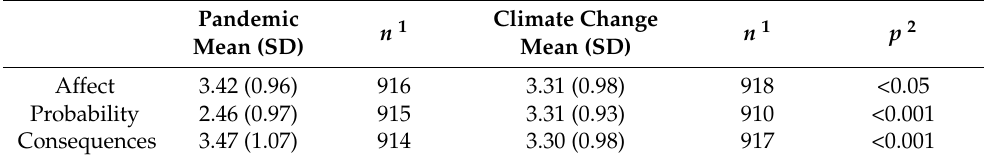
Table 4. Means of the dimensions of risk perception of the SARS-CoV-2 pandemic and climate change. Pandemic